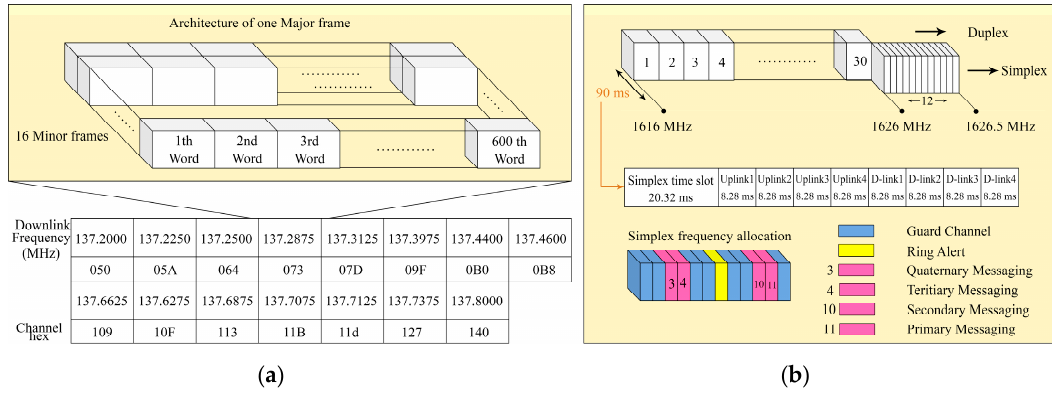
Figure 3. ( a ) Structure of Orbcomm downlink signals and ( b ) architecture of Iridium-Next downlink Figure3. ( a )StructureofOrbcommdownlinksignalsand( b signals.